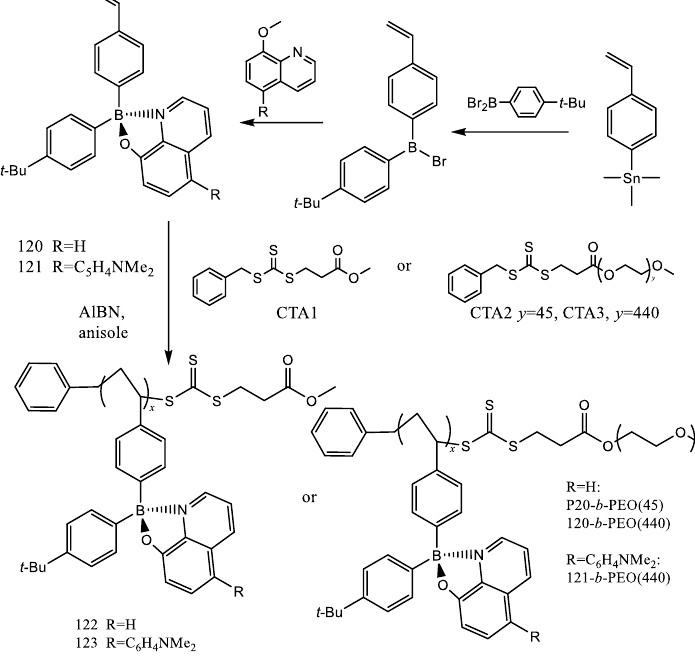
Scheme 21. Synthetic procedure for diboron complexes 116 – 119 .